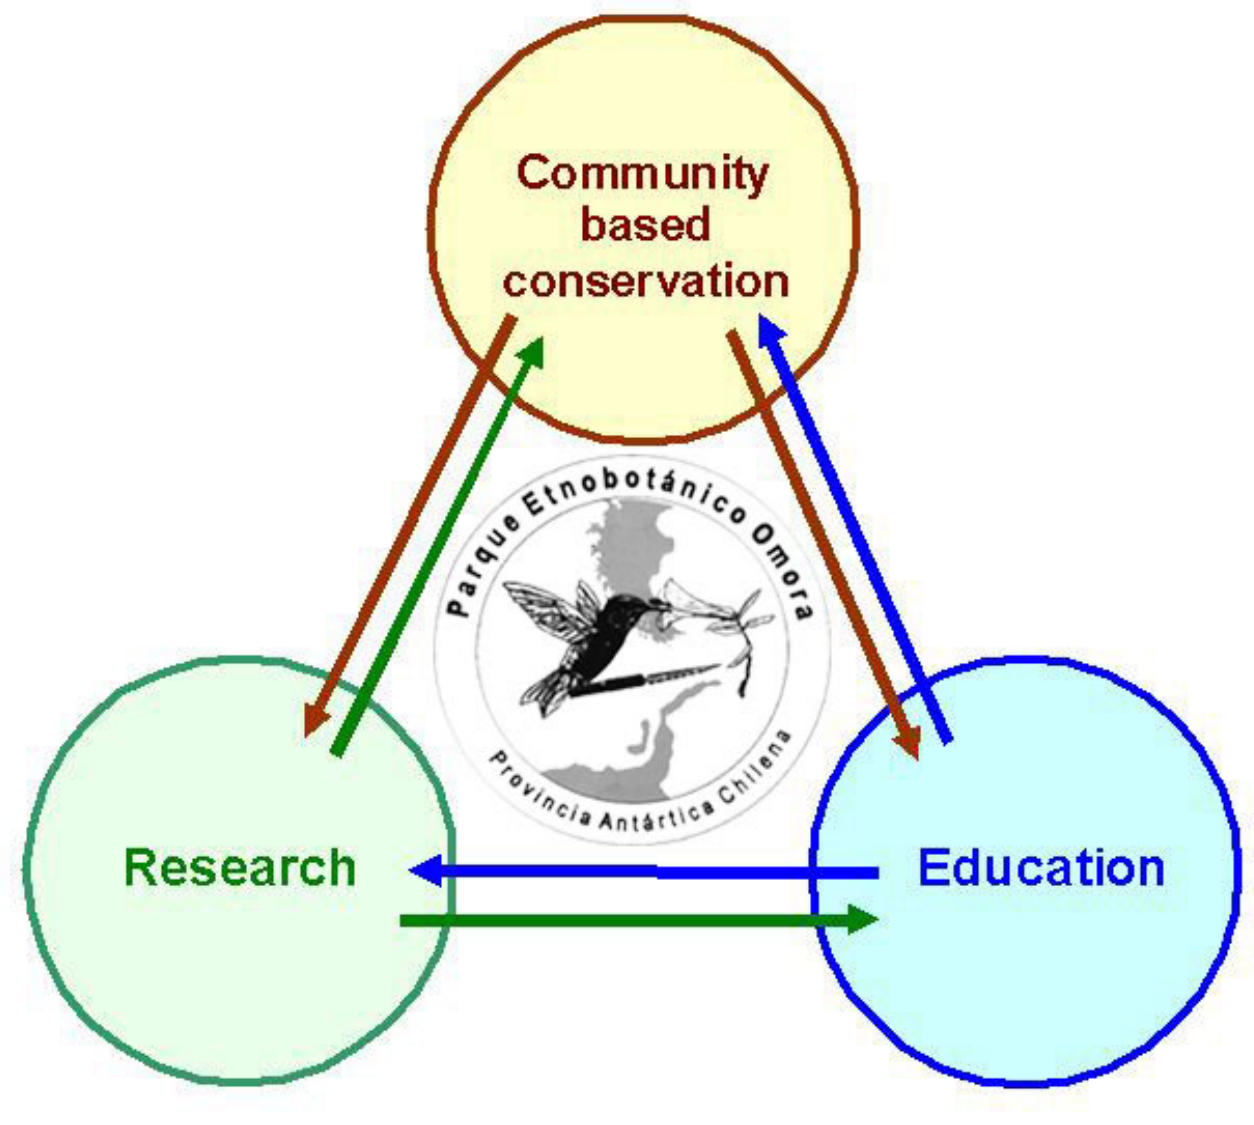
Fig. 3. Three main domains of action of the Omora Ethnobotanical Park initiative: (1) interdisciplinary scientific research; (2) formal and informal education, i.e., school, university, and training courses; and (3) biocultural conservation linked with local sustainable development. The triangle of these interrelated domains represents a local adaptation of the Ecological Society of America’s Sustainable Biosphere Initiative (ESA–SBI, Luchenco et al. 1991 a ). At the center, Omora’s logo illustrates the goals of integrating biological and cultural conservation through the image of the firecrown hummingbird ( Sephanoides sephaniodes ), or omora in the Yahgan language, visiting its preferred flower the coicopihue ( Philesia magellainica ), and carrying a harpoon, one of the main hunting tool used by the Yahgan indigenous